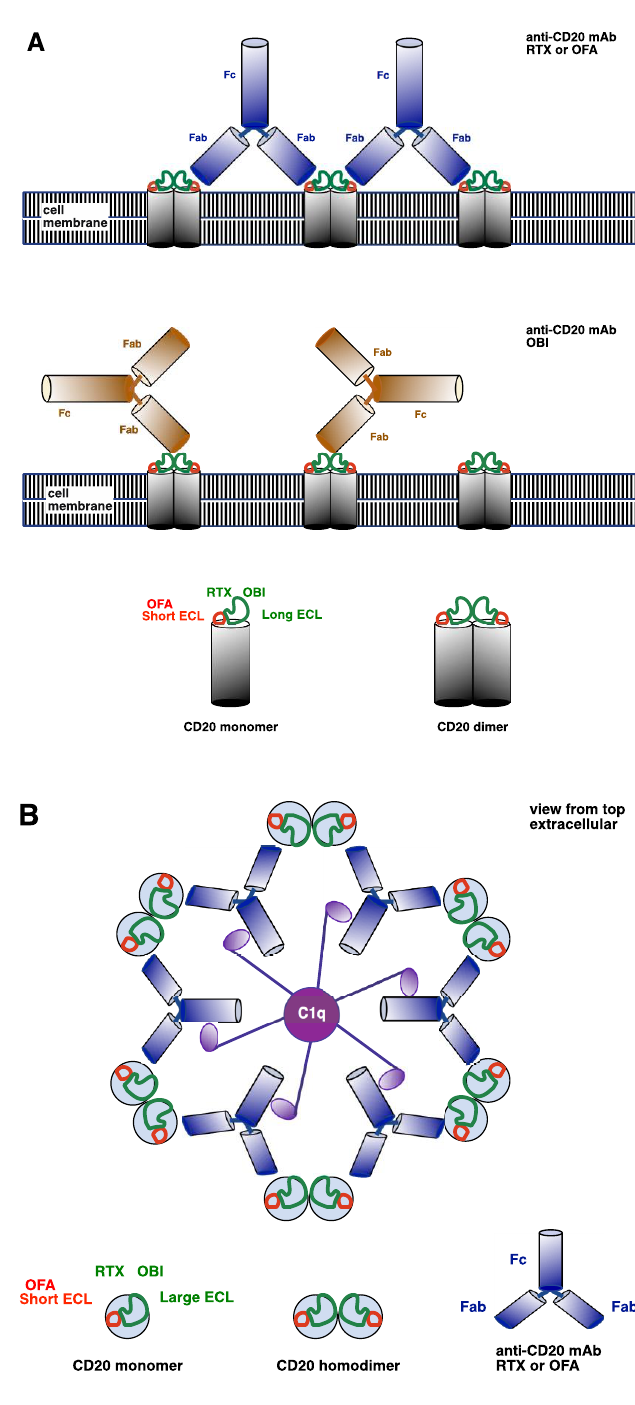
Figure 2. Anti-CD20 monoclonal antibody (mAb) ligation and activation of complement. ( A ) CD20 molecules form homodimers in the B-cell membrane. Rituximab (RTX) and obinutuzumab (OBI) ligate the long extracellular loop (ECL). RTX binds the long ECL in an area near the short ECL. OBI binds the long ECL in an area away from the short ECL. Ofatumumab (OFA) ligates the short ECL of the CD20 molecule. Type I complement-activating anti-CD20 mAb (RTX and OFA) Fabs can bind to two adjacent CD20 dimers. In contrast, the non-complement-activating anti-CD20 OBI binds only one CD20 dimer, resulting in a di ff erent Fc orientation to type I mAbs. ( B ) Model of the extracellular view from the top showing that type I anti-CD20 mAb RTX and OFA ligate adjacent CD20 dimers to form a hexamer that e ffi ciently activates